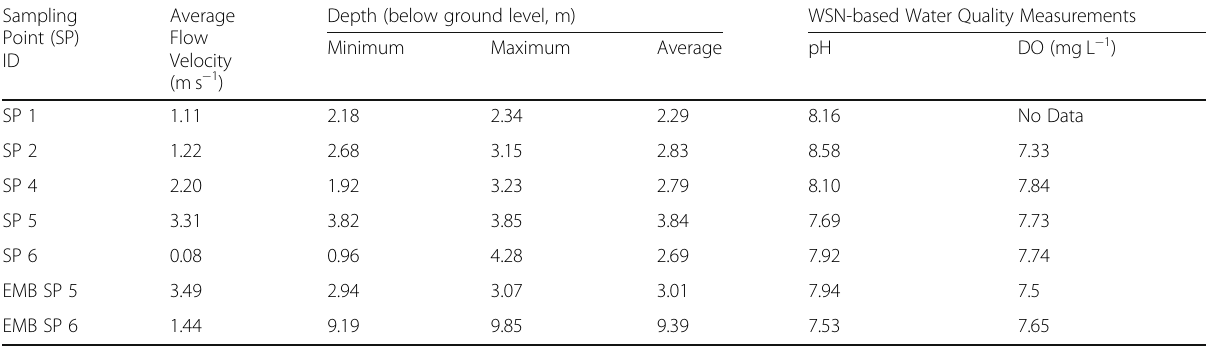
Table 2 The flow velocity data measured on site, GIS-based water depths derived from bathymetric data, and water quality data for pH and DO using WSN-based prototype Sampling Point (SP)